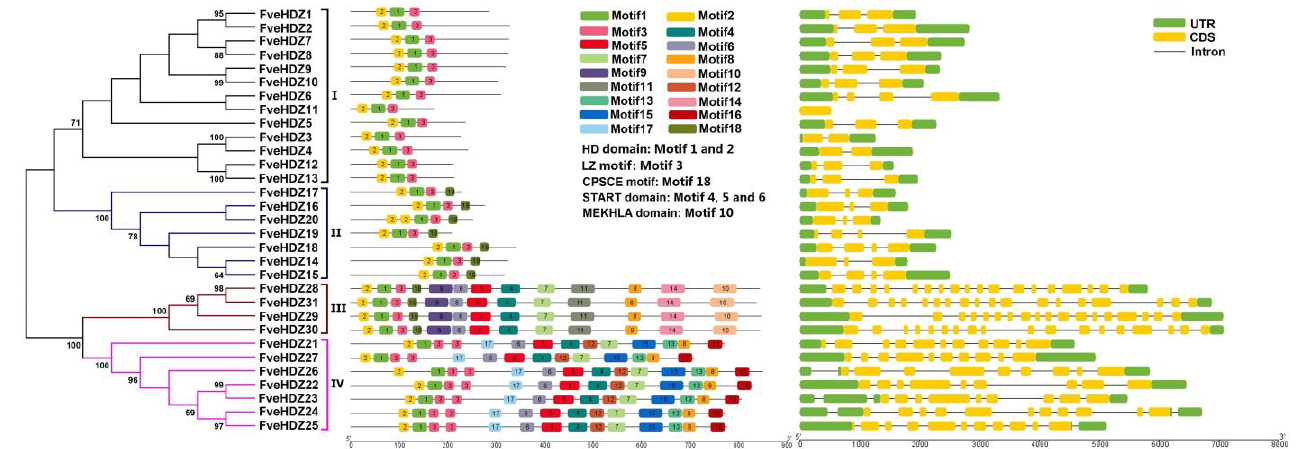
Figure 1. Evolutionary relationships ( left ), conserved motifs ( middle ), and gene structures ( right ) of HD-ZIP family genes in F. vesca . The unrooted neighbor-joining phylogenetic tree was constructed using MEGA10 based on the full-length sequences of the 31 FveHDZ proteins. Bootstrap values > 50 are shown. Genes in the subfamilies I-IV are indicated by different color blocks and lines in the phylogenetic tree. The motifs, numbered 1–20, were displayed in different colored boxes.